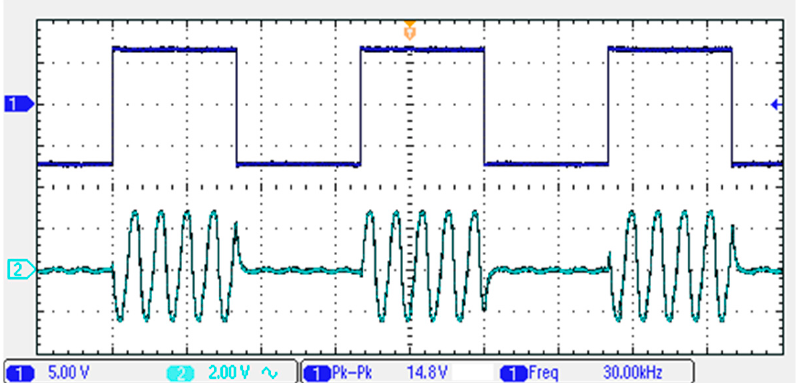
Figure 19. Measured result of operation as an AM signal generator (channel 2) when I B 2 is the applied pulse signal (channel 1).